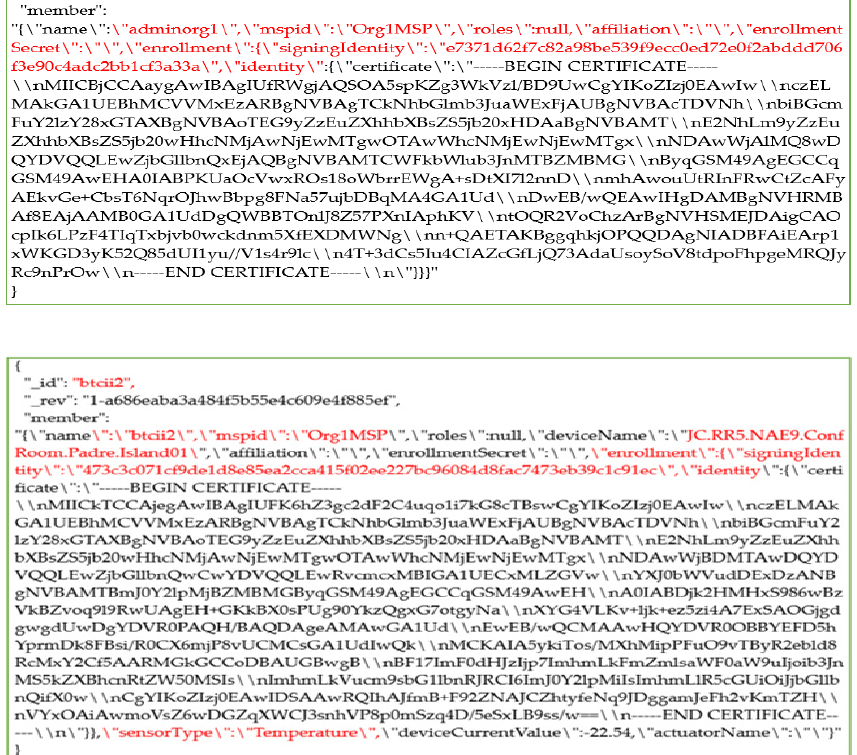
Figure 9. Secret keys and certificates of admin and device on organization 1.